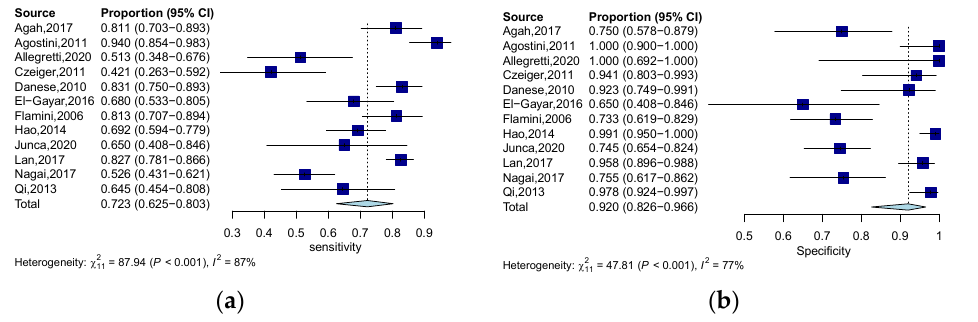
Figure 3. Forest plots of SEN ( a ) and SPE ( b ) for the diagnostic value of ctDNA assay for CRC in the quantitative detection subgroup. 95% CI, 95% confidence interval; CRC, colorectal cancer; ctDNA, circulating tumor DNA; SEN, sensitivity; SPE, specificity; diamond shapes representing average effect; dark blue squares representing individual study results.